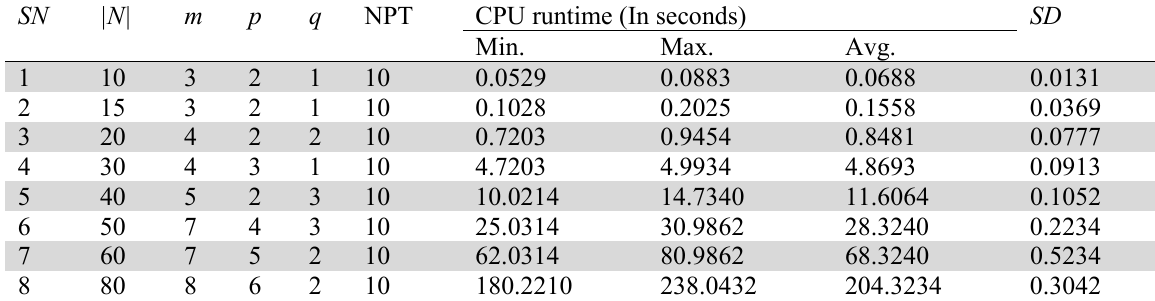
SN –Serial Number; |N| – Number of cities; m – Number of salesmen; p – Number of internal salesmen; q –Number of external salesmen; NPT–Number of problems tried; Min.–Minimum CPU runtime required for finding best solution; Max.–Maximum CPU runtime required for finding best solution; Avg.– Average CPU runtime required for finding best solution; SD – Standard deviation of CPU